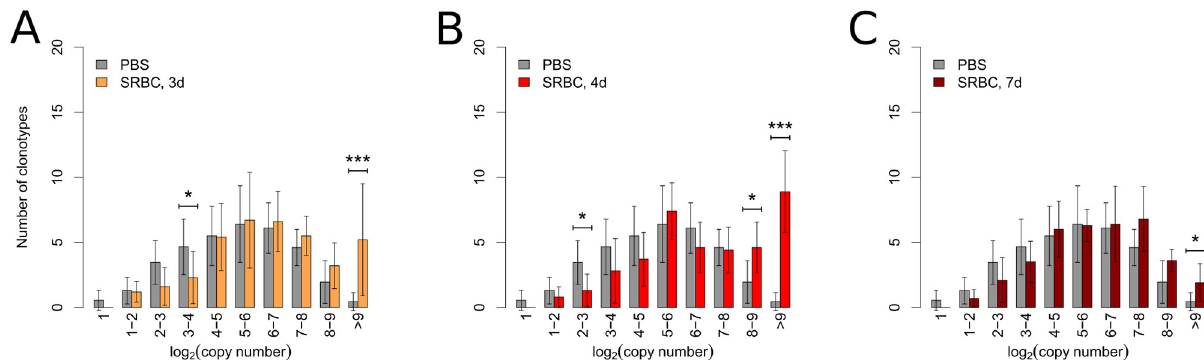
Fig 4. Expanding public clonotypes distribute throughout the repertoire and accumulate in the fraction of highest copy number after immunization. 40 clonotypes detected in the majority of immunized animals and found significantly expanded after SRBC injection were defined as (presumably) SRBC-specific public clonotypes. Their distribution throughout the 10 fractions defined by copy number based on the logarithm of the base 2 in PBS-injected control animals is indicated by grey bars compared to animals 3 days (d) (A), 4d (B) and 7d (C) after immunization with SRBC. Barplots state number of SRBC-specific clonotypes per fraction for control (n = 20) and immunized (n = 10 for each time point) mice. Bars and whiskers display means and standard deviations. For each time point control and immunized animals were compared using the Mann-Whitney-U-test with resulting p -values displayed as � p < 0.05, ��� p < 0.001. p -values were corrected for multiple testing using Holm’s